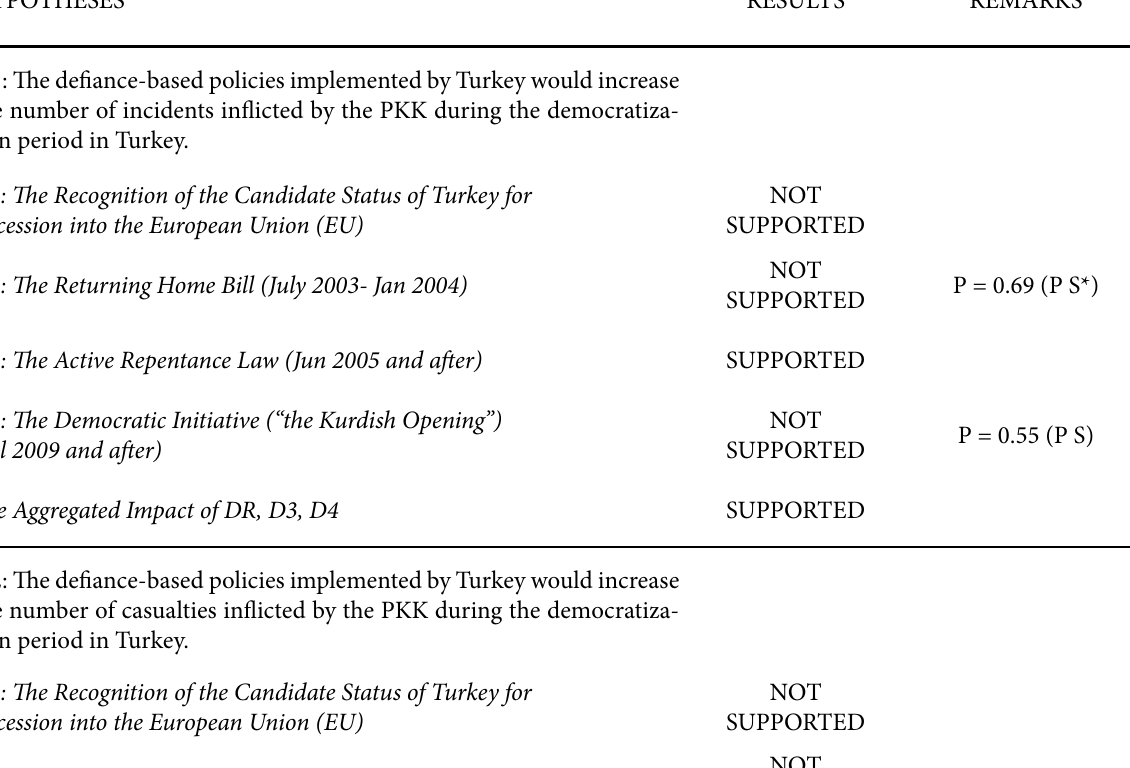
Table 4: Hypotheses Results